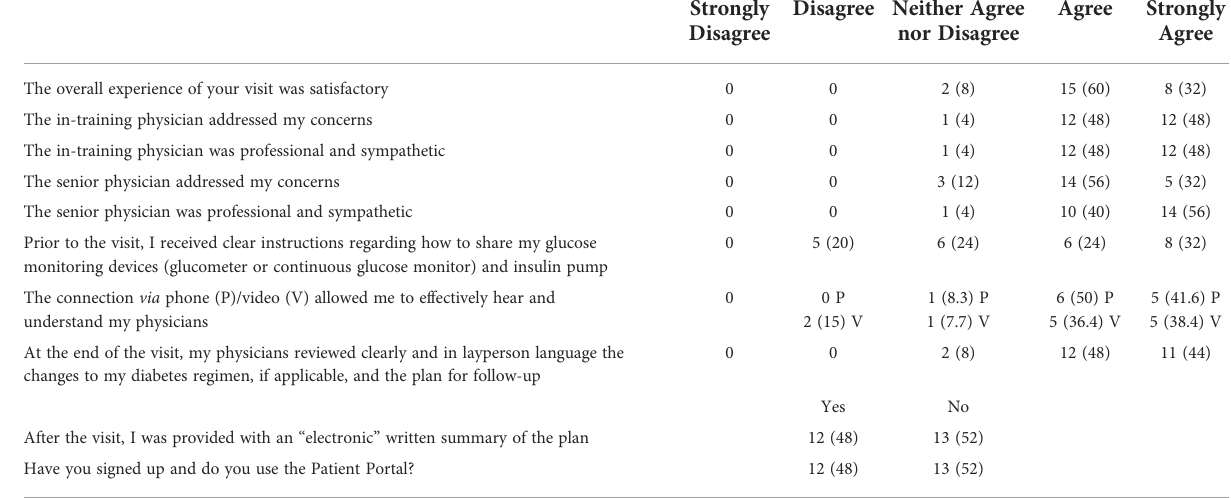
TABLE 2 Survey on remote visit experience for people with diabetes.